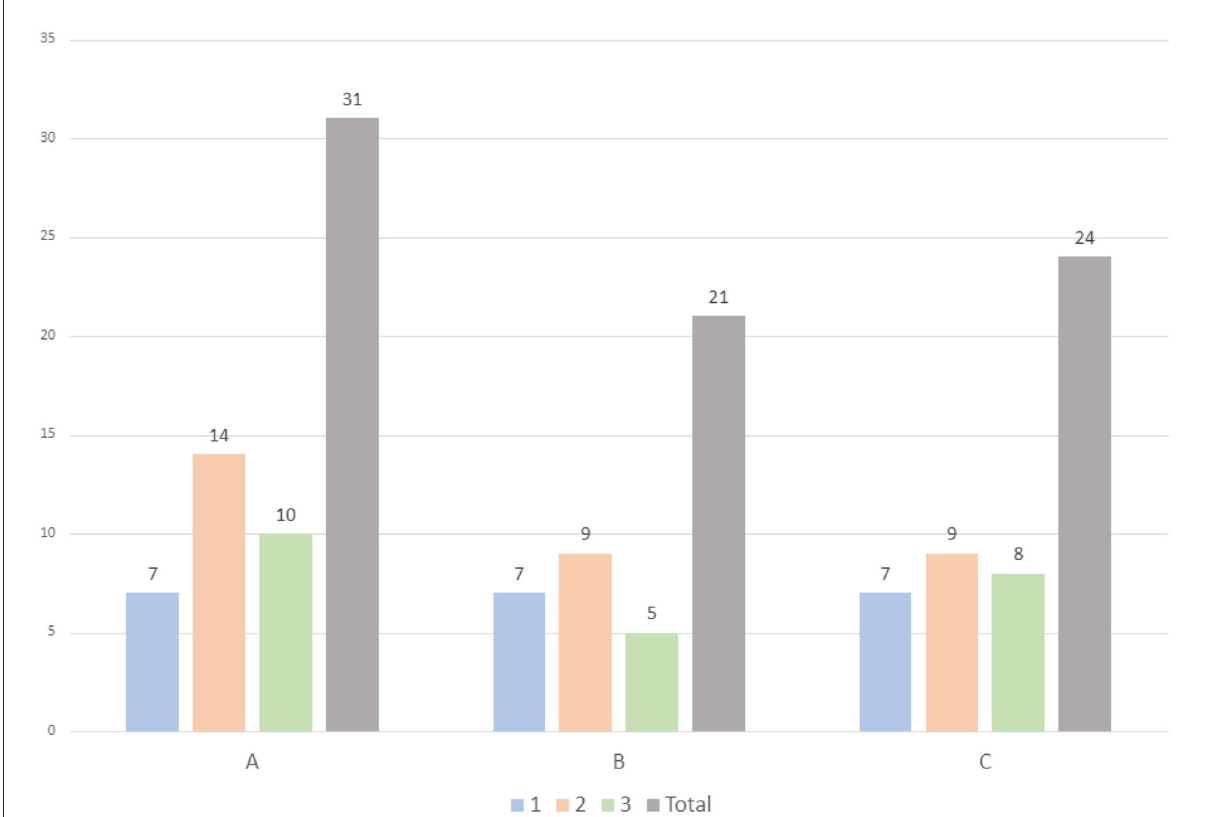
FIGURE3 Total number of returning bees per study cover regions (A, B, C) and subbuffers (1, 2, 3, and